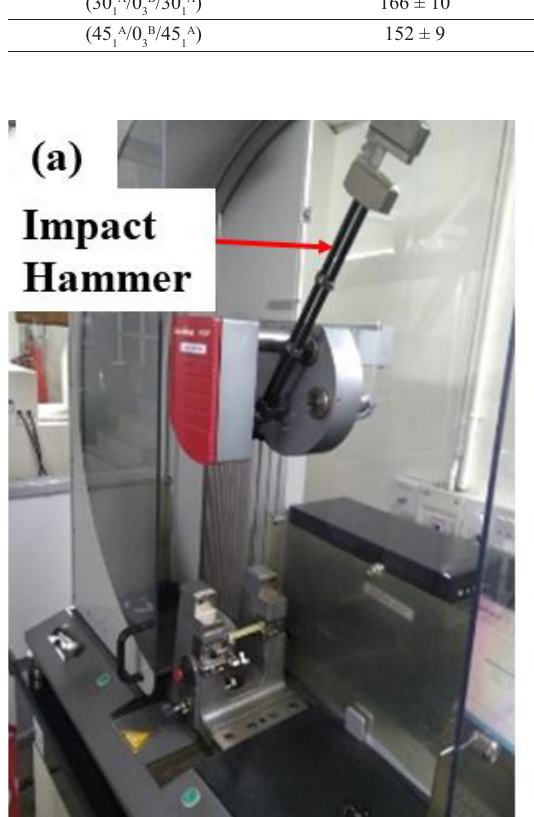
Figure 5. (a) Impact test setup (b) Specimen with specimen holder.